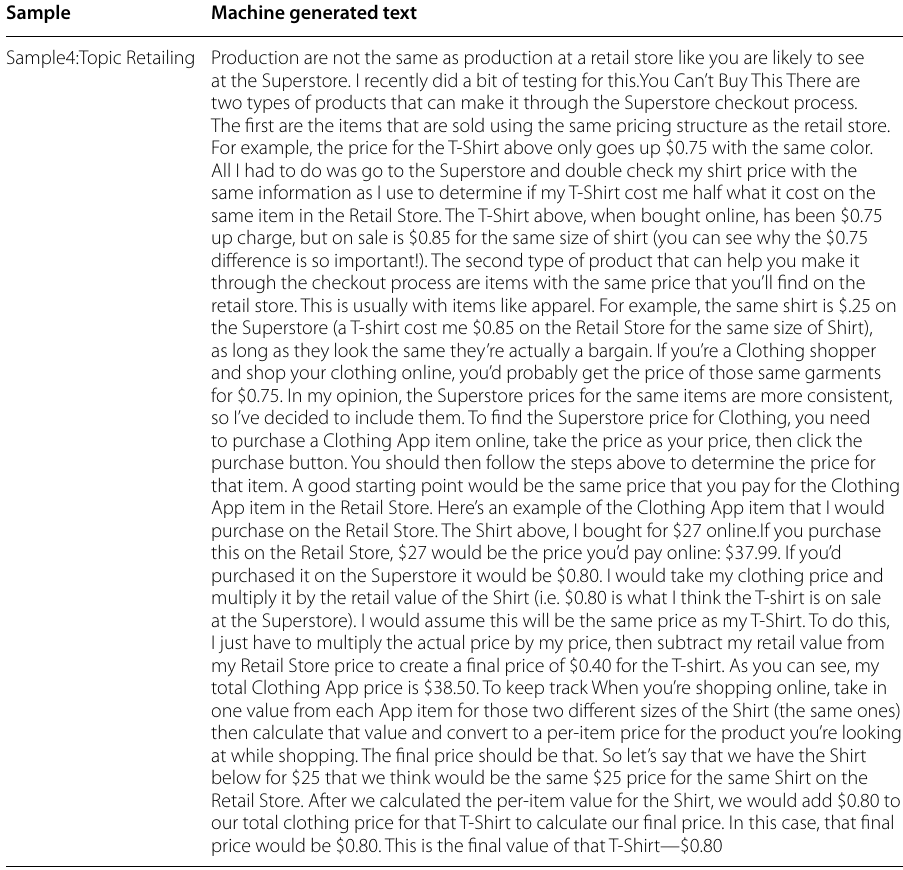
Automatic output generated by the trained model